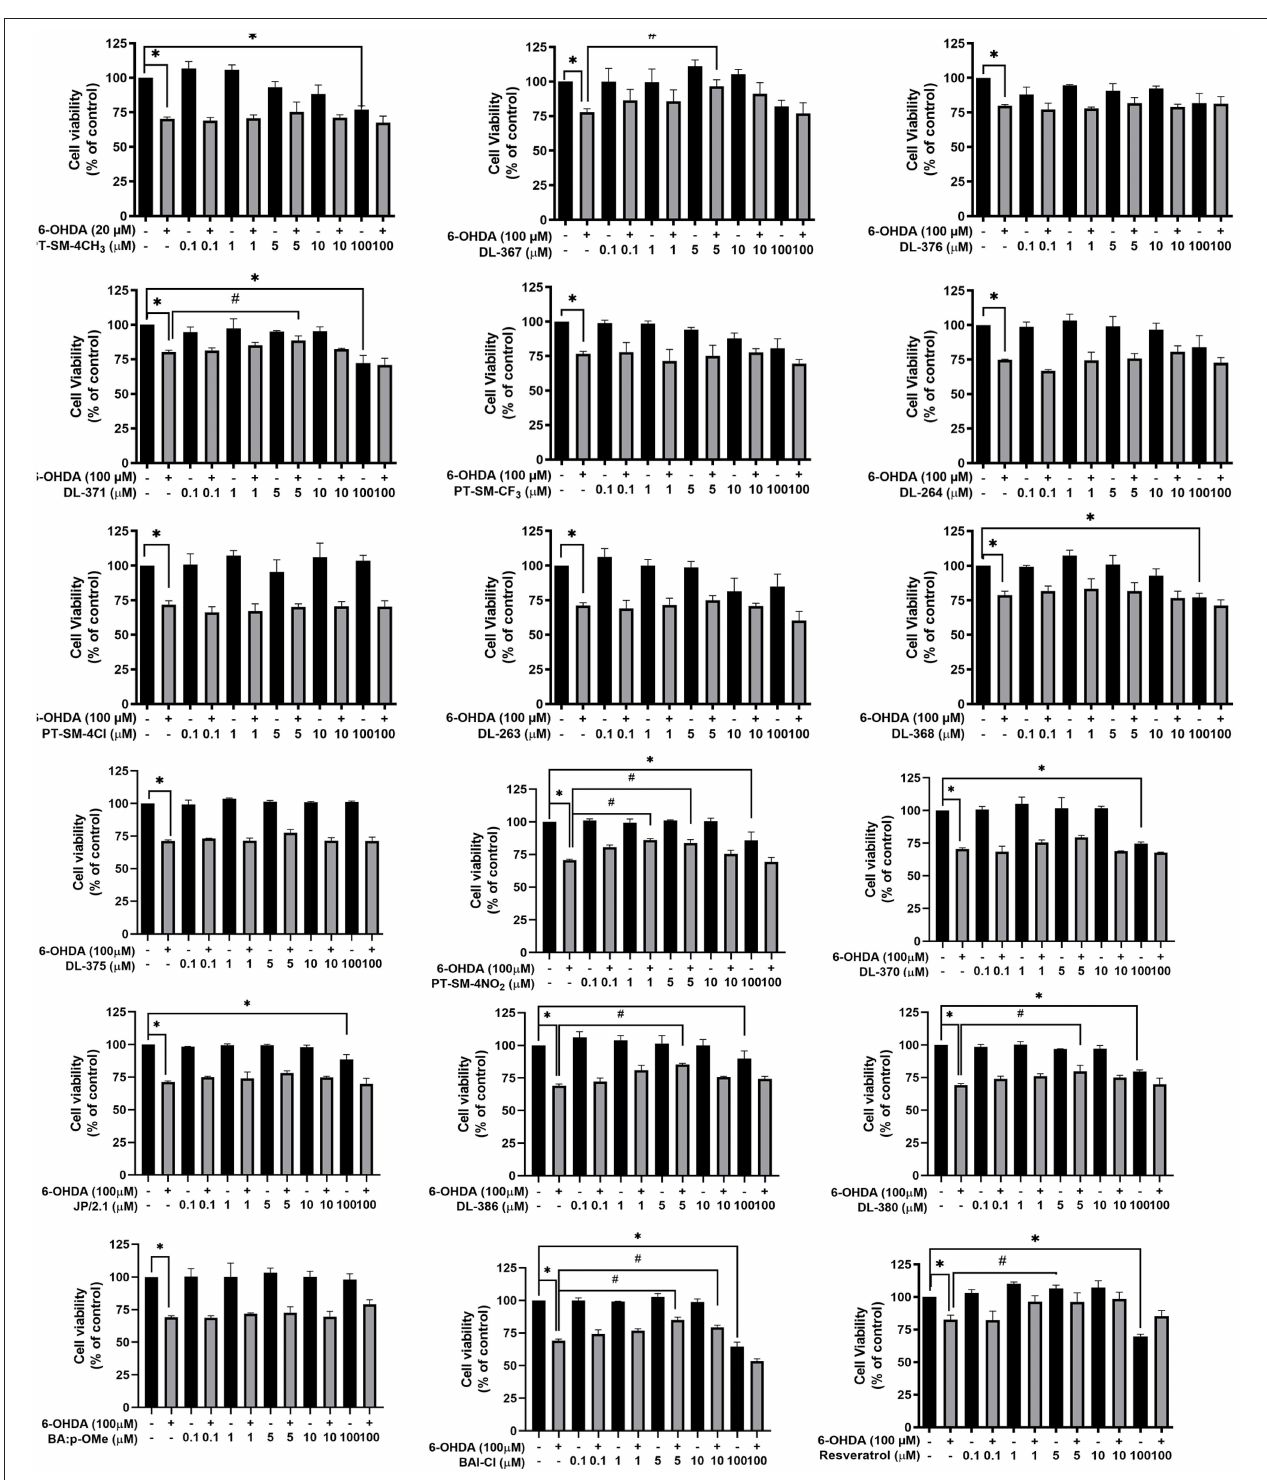
FIGURE 2 | Bis-sulfonamides were studied in neuroblastoma SH-SY5Y cells for their neuroprotective effects. The SH-SY5Y cells (1 × 10 5 cells/ml) were cultivated in 96-well plates for 24h. The plates were then incubated for 3h with various doses of bis-sulfonamides or resveratrol (0.1–100 µ M), followed by another 24h with 100 µ M of 6-hydroxydopamine (6-OHDA) and evaluated by MTT assay. The data are expressed as mean ± SEM, and statistical analysis was performed using one-way ANOVA. * P < 0.05 compared with the control; # P < 0.05 compared with the 6-OHDA.